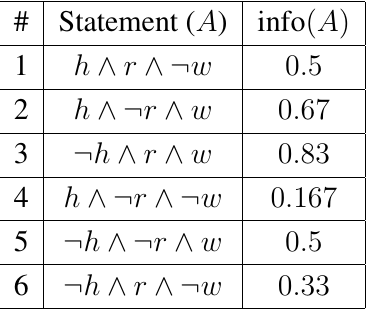
Table 6. Results with adjusted